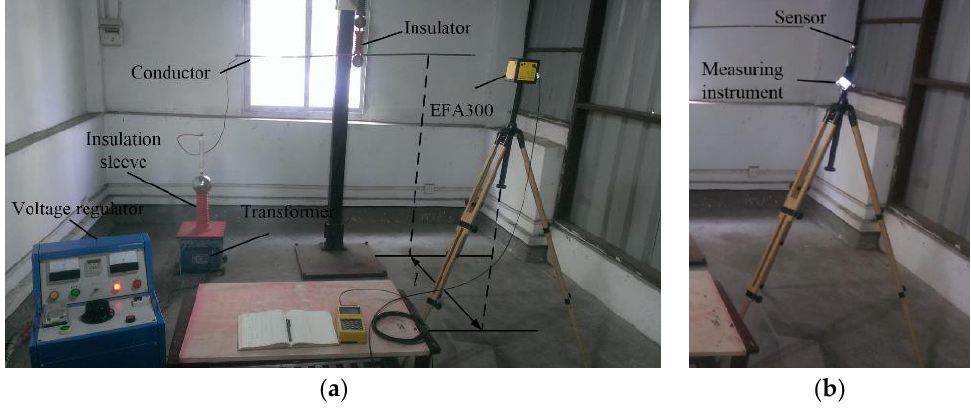
Figure 8. Experimental environment. ( a) Using EFA-300. ( b ) Using the designed instrument.